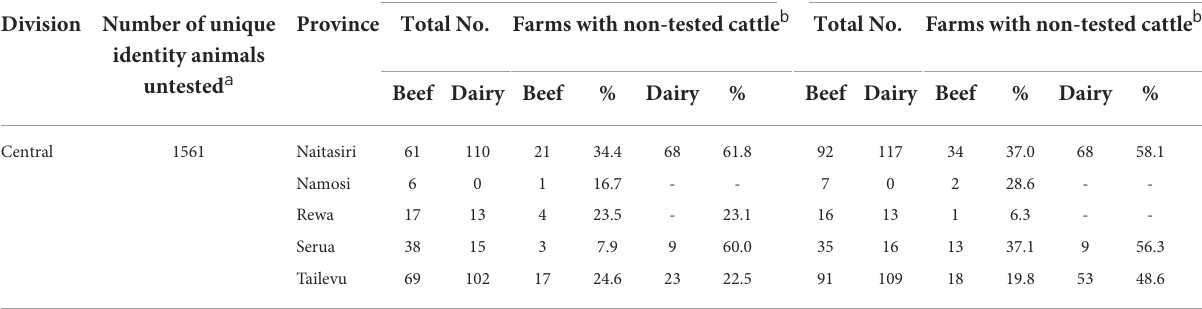
TABLE 7 Proportion of beef and dairy farms in Central Division with untested animals in 2019 and